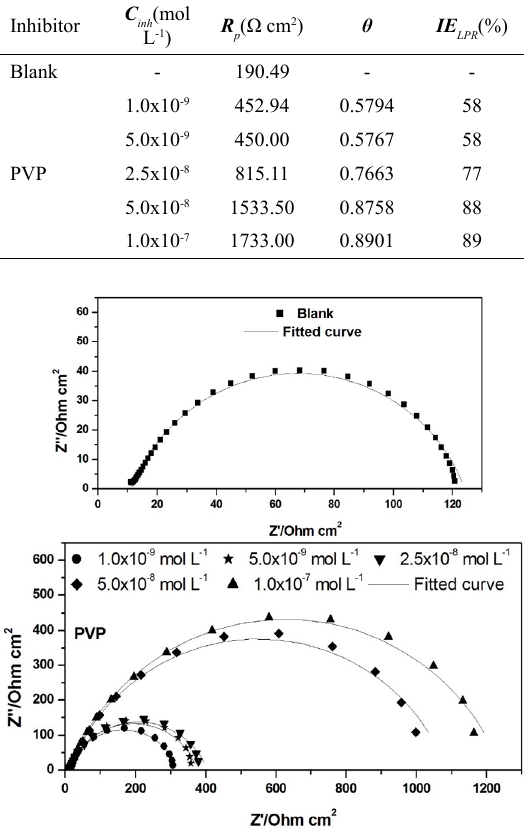
Figure 6. Bode plots of carbon steel obtained in 0.5 mol L -1 HCl, in the presence and the absence of